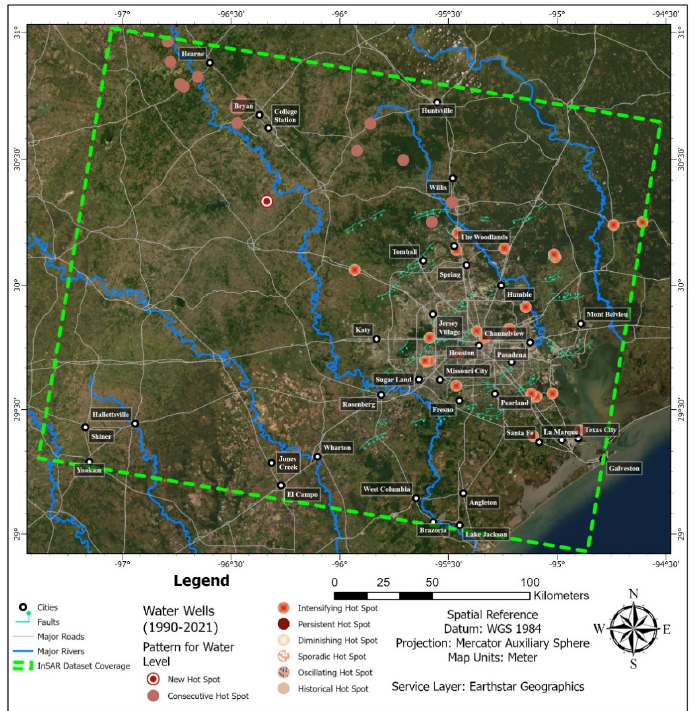
Figure 5. Emerging hot spot results for the groundwater level change in Houston and surrounding areas. A neighborhood distance of 3 km was used and only the eight hot spot (high value trend) categories were shown.